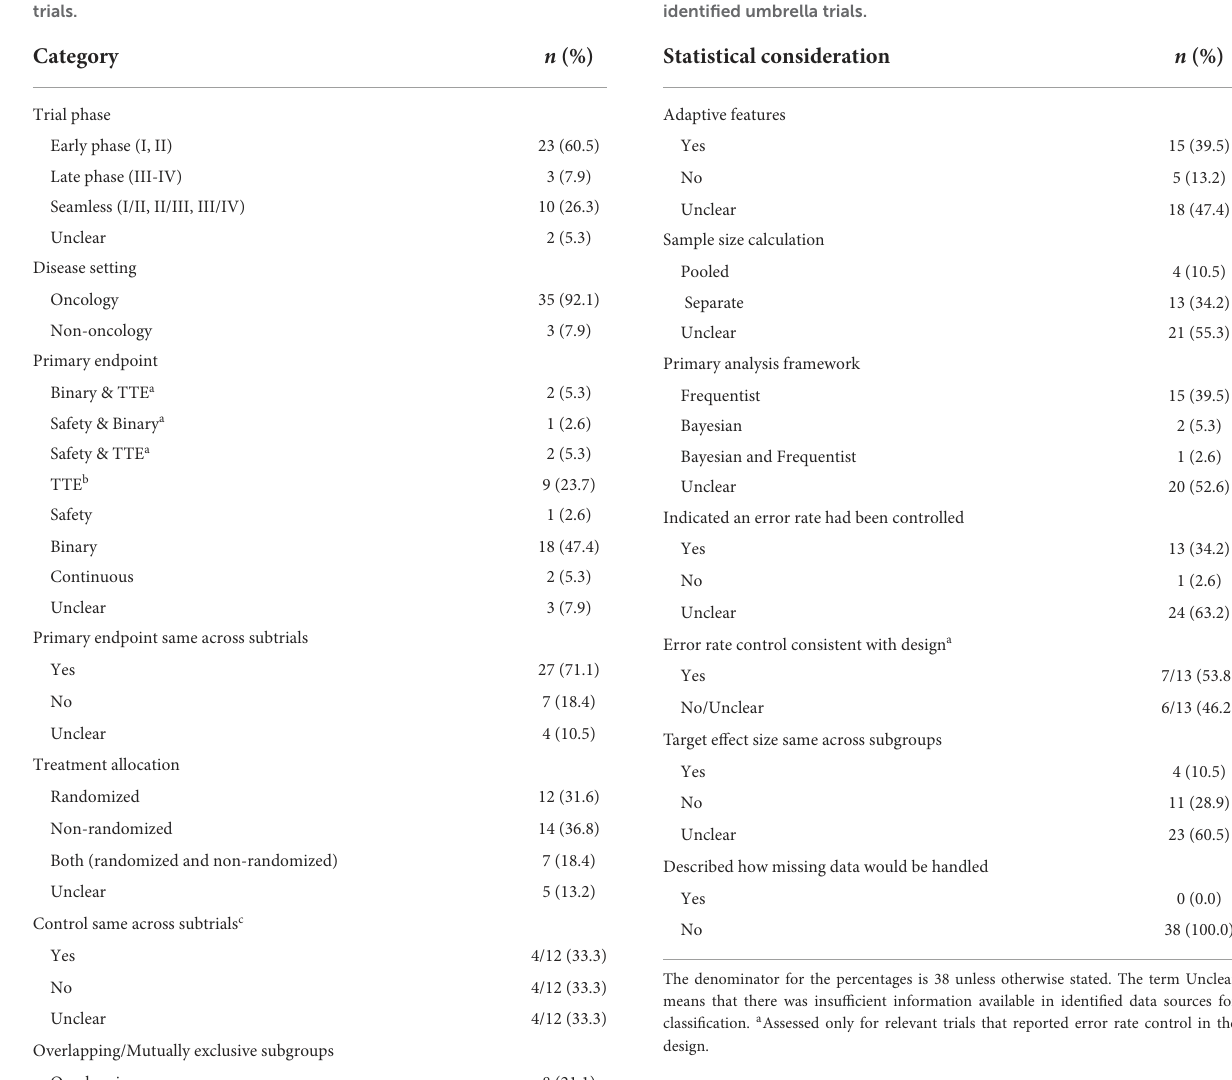
TABLE 1 Overview of the characteristics of the 38 identified umbrella trials.